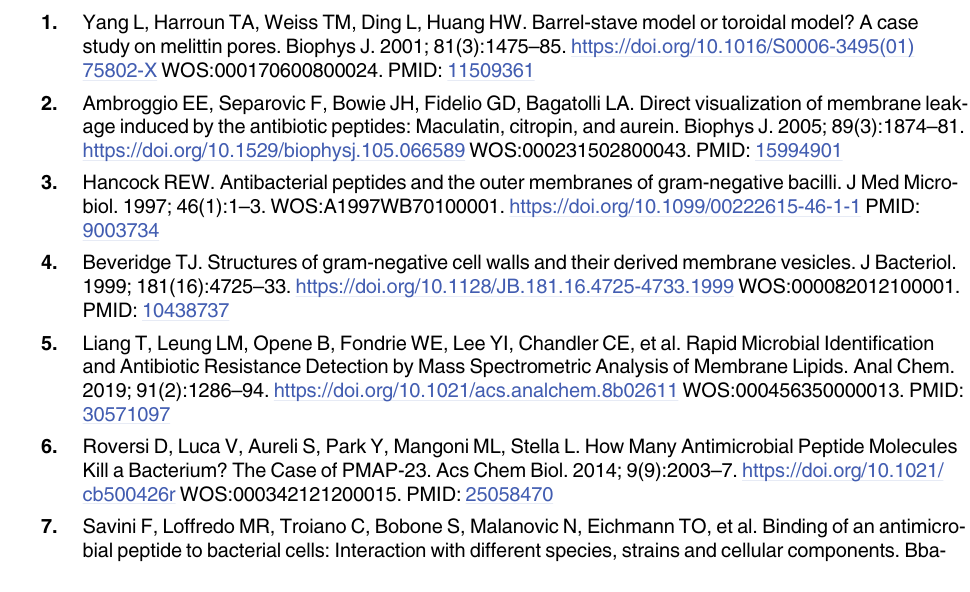
S1 Table. Tabulated data displayed in Fig 1 of the